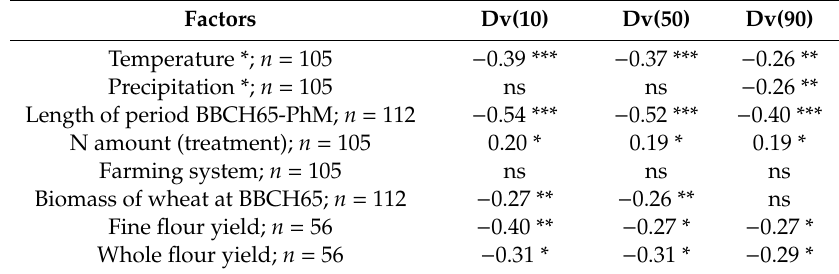
Table 2. Correlation between starch granules size distribution and several factors studied in this trial. Factors Dv(10) Dv(50) Dv(90) Temperature *; n = 105 − 0.39 *** − 0.37 *** − 0.26 ** Precipitation *; n = 105 ns ns − 0.26 ** Length of period BBCH65-PhM; n = 112 − 0.54 *** − 0.52 *** − 0.40 *** N amount (treatment); n = 105 0.20 * 0.19 * 0.19 * Farming system; n = 105 ns ns ns Biomass of wheat at BBCH65; n = 112 − 0.27 ** − 0.26 ** ns Fine flour yield; n = 56 − 0.40 ** − 0.27 * − 0.27 * Whole flour yield; n = 56 − 0.31 * − 0.31